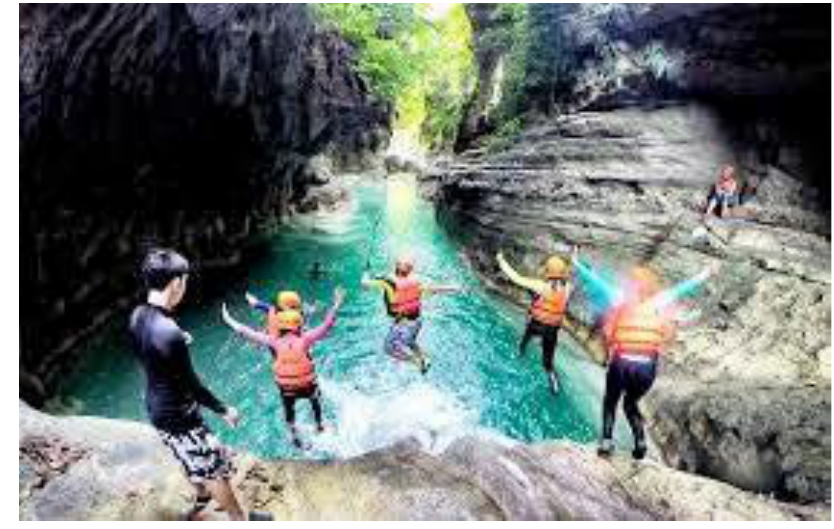
Figure 5. One of the activities people relished in Kawasan is the Canyoneering